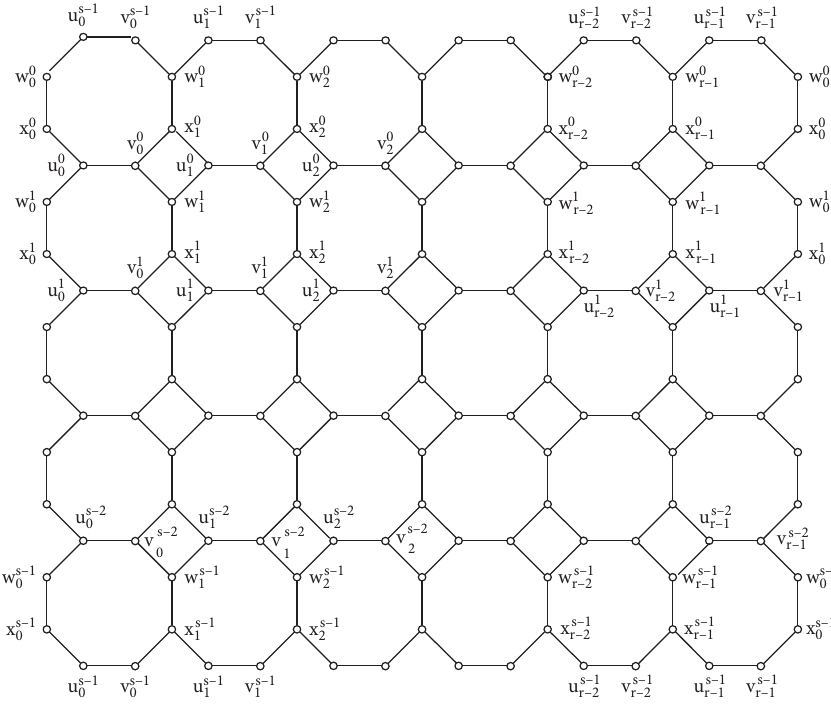
Figure 2: Toroidal octagonal map identification O r